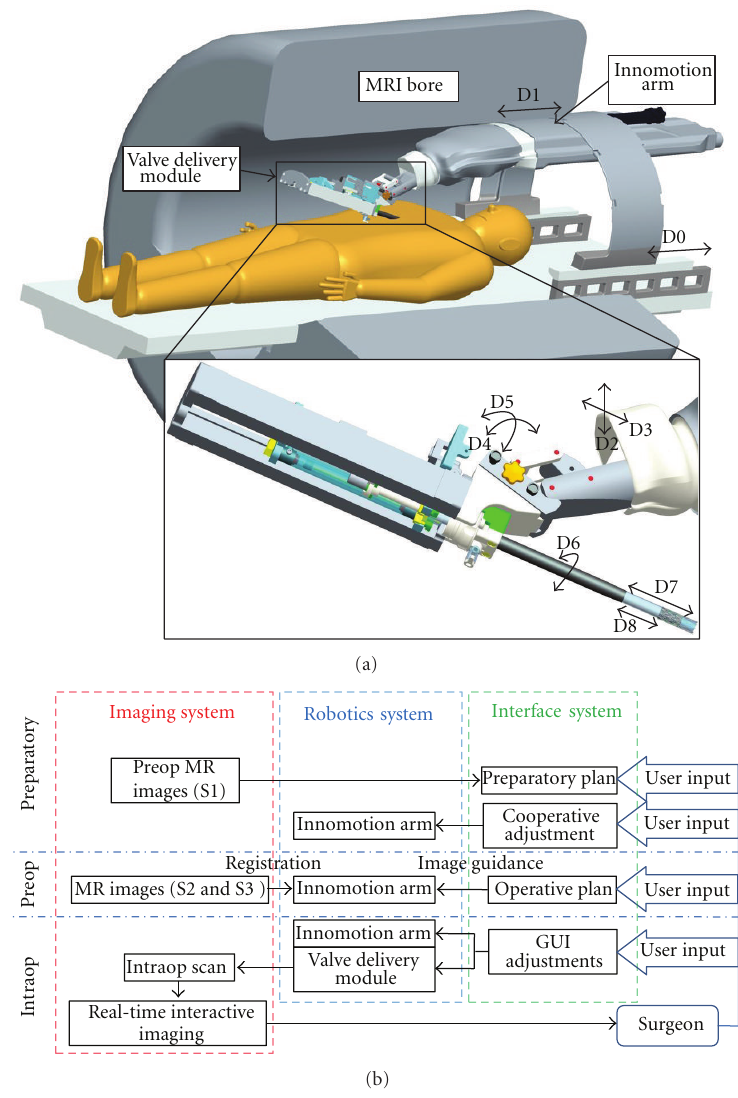
Figure 4: (a) A CAD sketch of the robotic system with patient inside an MRI bore. (b) Diagram showing connections between di ff erent subsystems and interactions of the physician with the